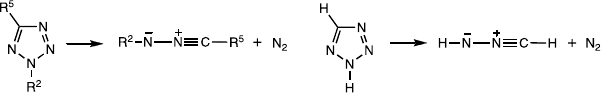
Figure 1. Ring opening of N 2 -substituted tetrazoles.